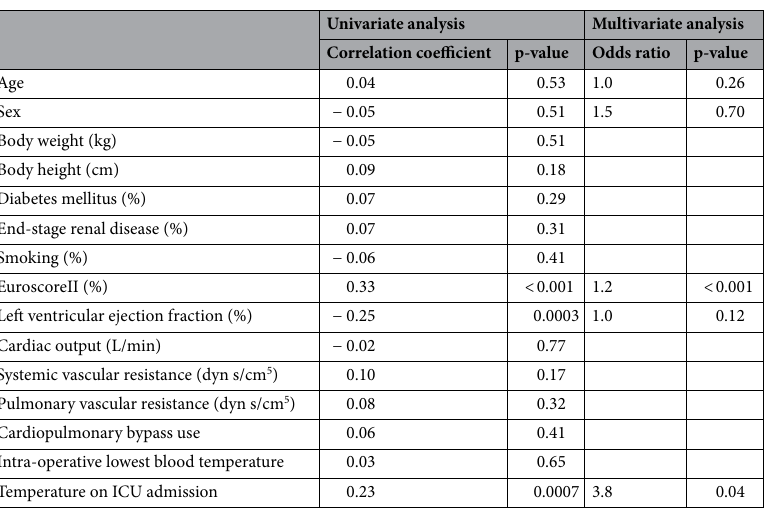
Table 3. Univariate analysis for risk factors affecting ICU stay in CABG patients. ICU intensive care unit, CABG coronary artery bypass